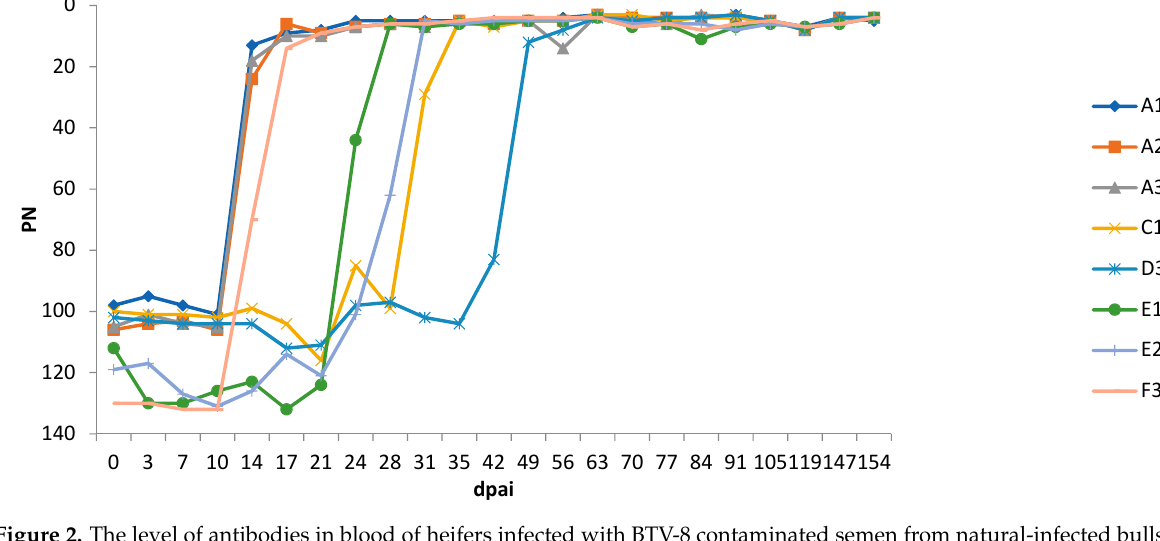
Figure 3. The body temperature of heifers infected with BTV-8 contaminated semen from natural-infected bulls until 35 days post-artificial insemination (dpai); thereafter, temperature remained normal. In group B, which received a 30-times lower viral dose than group A, pregnancy was maintained throughout the study period in all heifers, with no evidence of infection, remaining clinically normal and negative for viral genome and antibody throughout the study. Neither the gross pathology nor the histopathology could identify any abnormality in the organs or tissues of the foetuses recovered after induced expulsion. BT viral genome was not detected in foetal spleen or brainstem. In group C, which received a similar viral dose as group B, BTV RNA was found in the blood of one heifer (heifer C1; Table 1) at 24 dpai and antibodies were detected in serum from 31 dpai (Figures 1 and 2). This heifer showed a similar strong and long-lasting viraemia to that seen in heifer A3 but starting 2 weeks later. BTV could be isolated at 28 dpai and the animal also remained seropositive at a high level. Early pregnancy loss (40